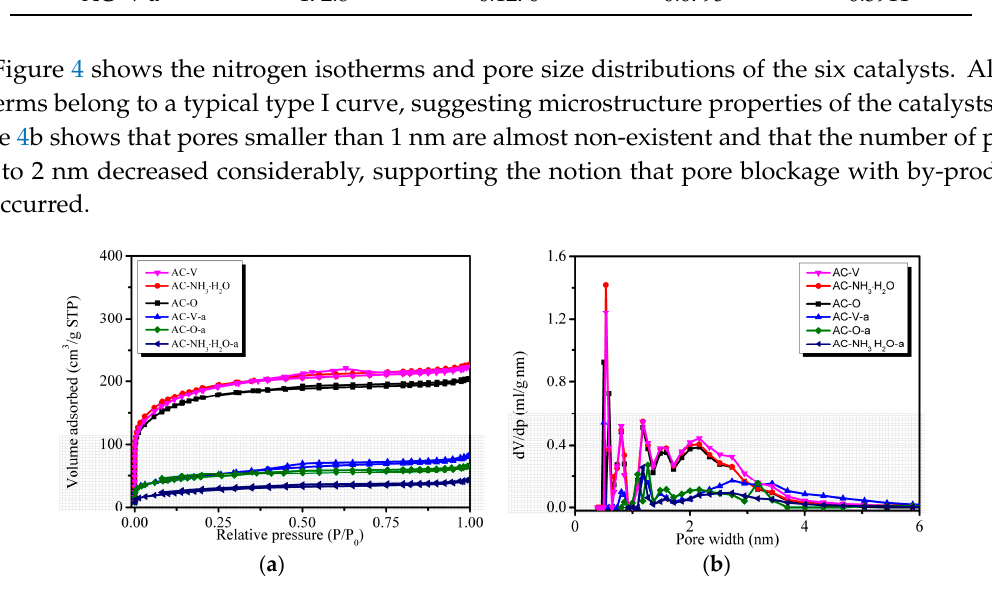
Figure 4. ( a ) Low ‐ temperature nitrogen adsorption–desorption isotherms, and ( b ) Pore size Figure 4. ( a ) Low-temperature nitrogen adsorption–desorption isotherms, and ( b ) Pore size distribution distribution patterns of different catalysts. patterns of different